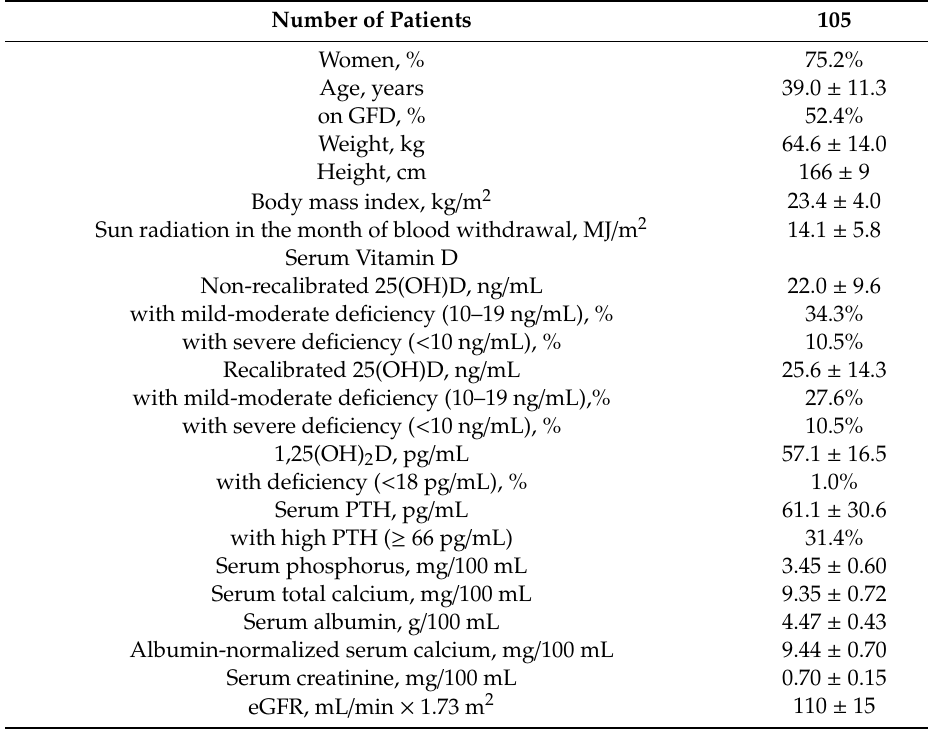
Table 1. Descriptive statistics for patients with lab tests: Mean ± SD or prevalence.